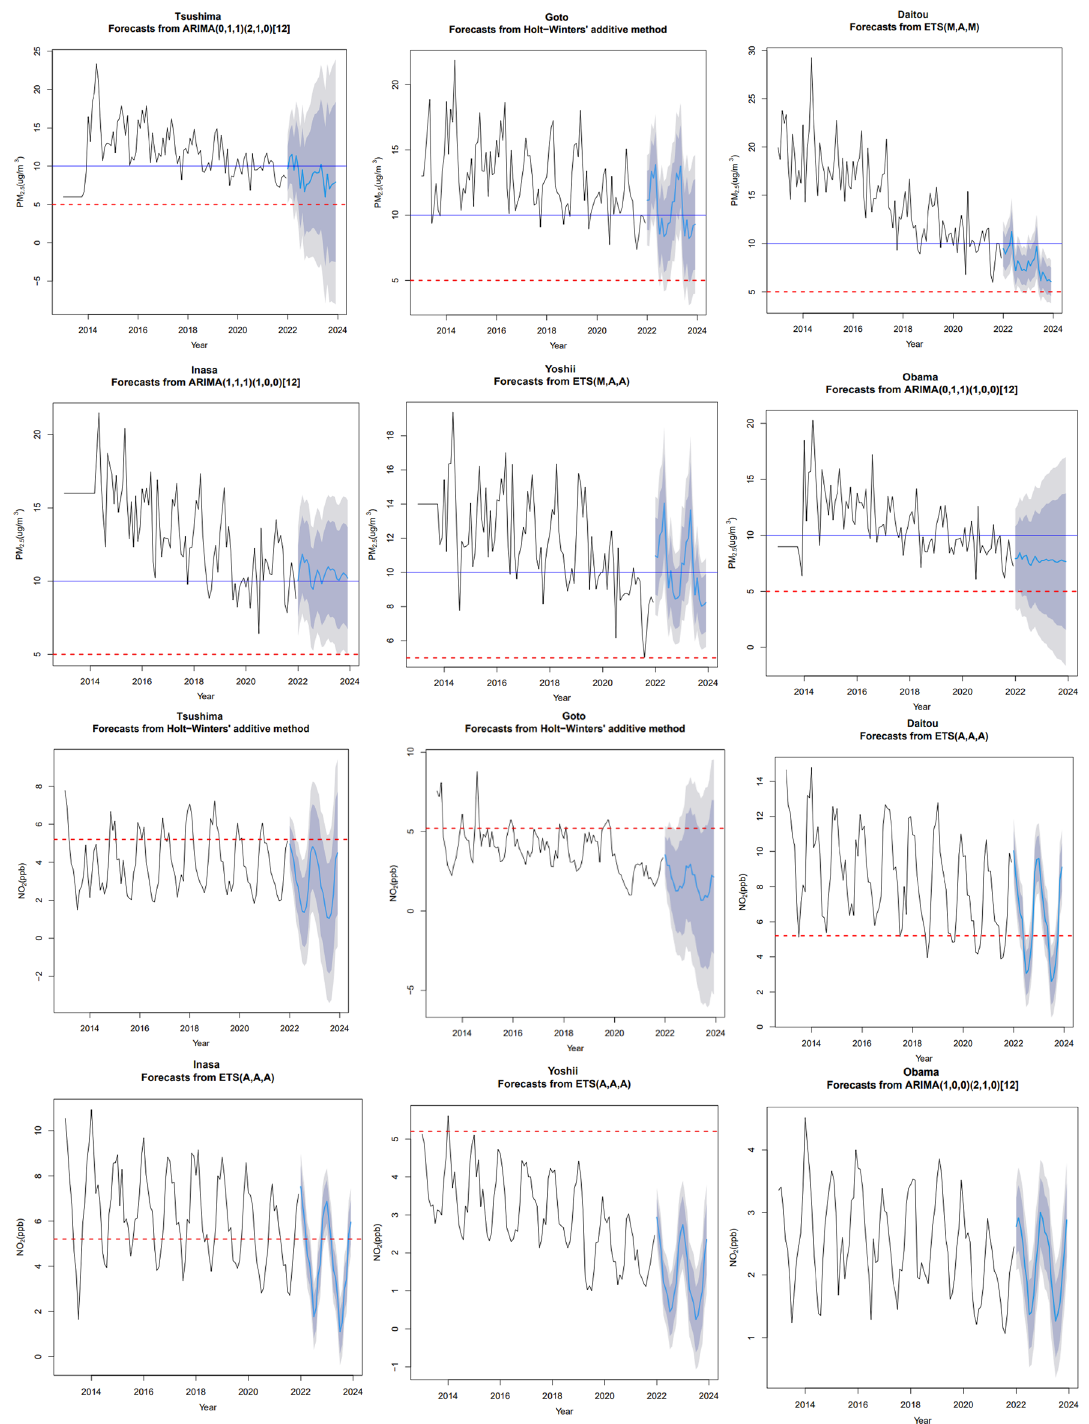
Figure 6. Models and Forecast of PM 2.5 and NO 2 for different monitoring stations in Nagasaki Prefecture, Japan. Blue and red lines represent the WHO PM 2.5 and NO 2 recommendations for 2005 and 2021,